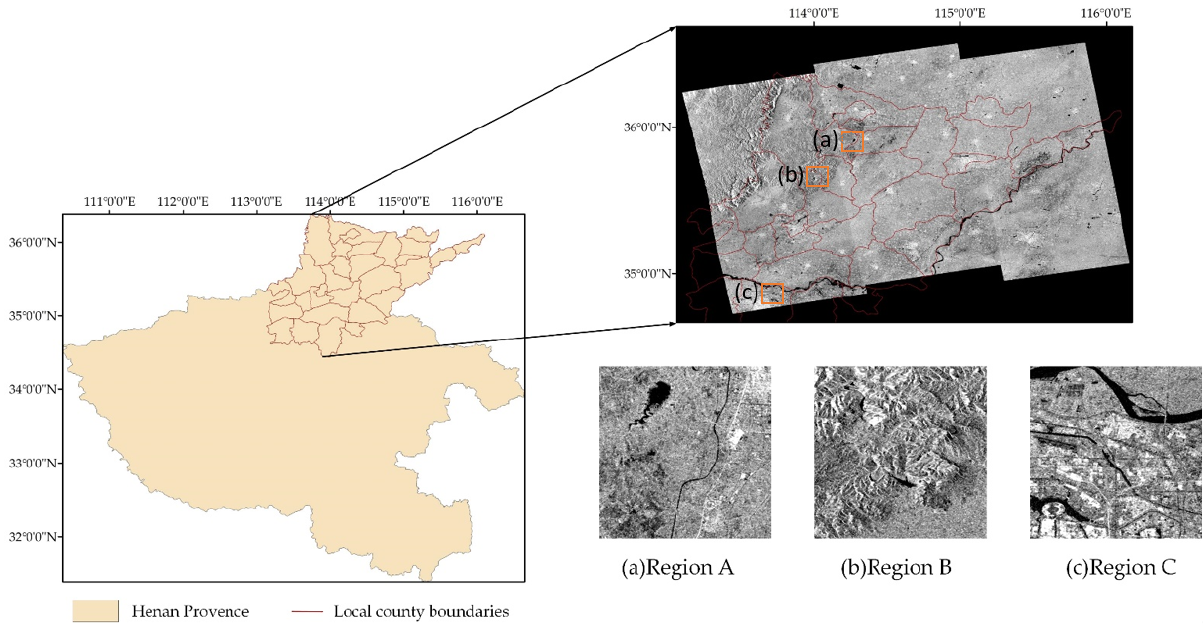
Figure 9. SAR image and the selected areas for validation. ( a ) Region A. ( b ) Region B. ( c ) Region C.